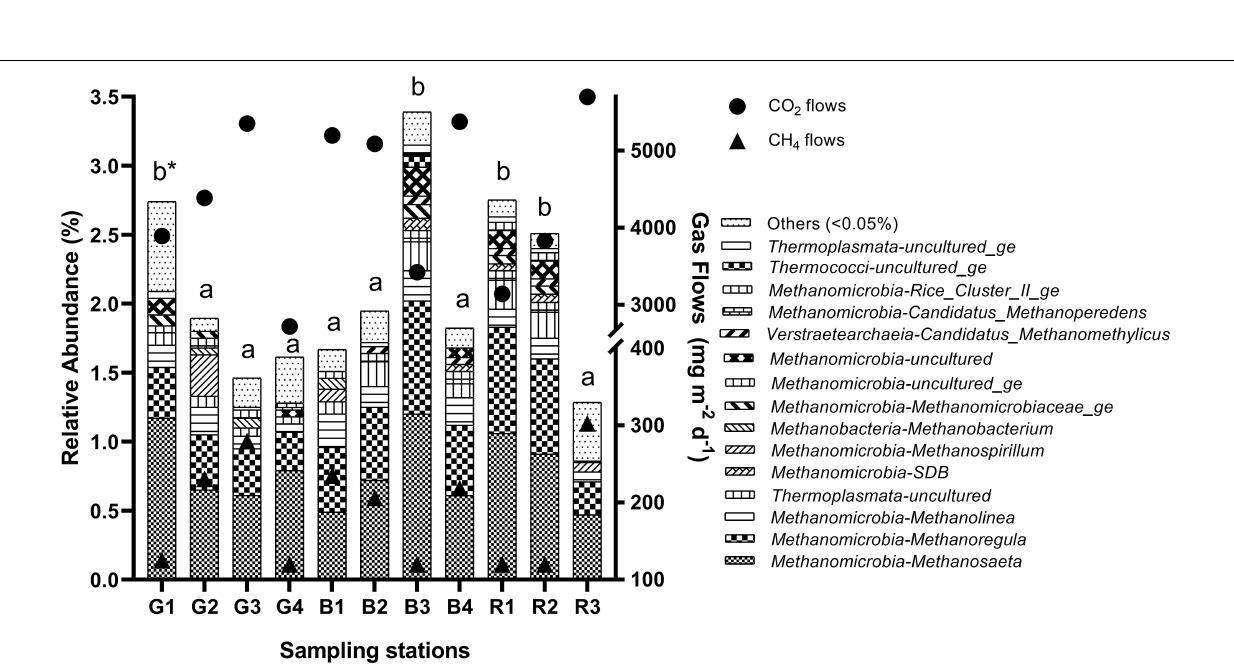
FIGURE 2 | Relative abundance of methanogenic archaea genera in the sediments of reservoirs and the atmospheric CO 2 and CH 4 flows throughout the seasons. “Others” refers to a group of genera with abundances lower than 0.05%. *Means with equal letters do not differ by the Scott–Knott test at 5% significance to methanogens abundance.